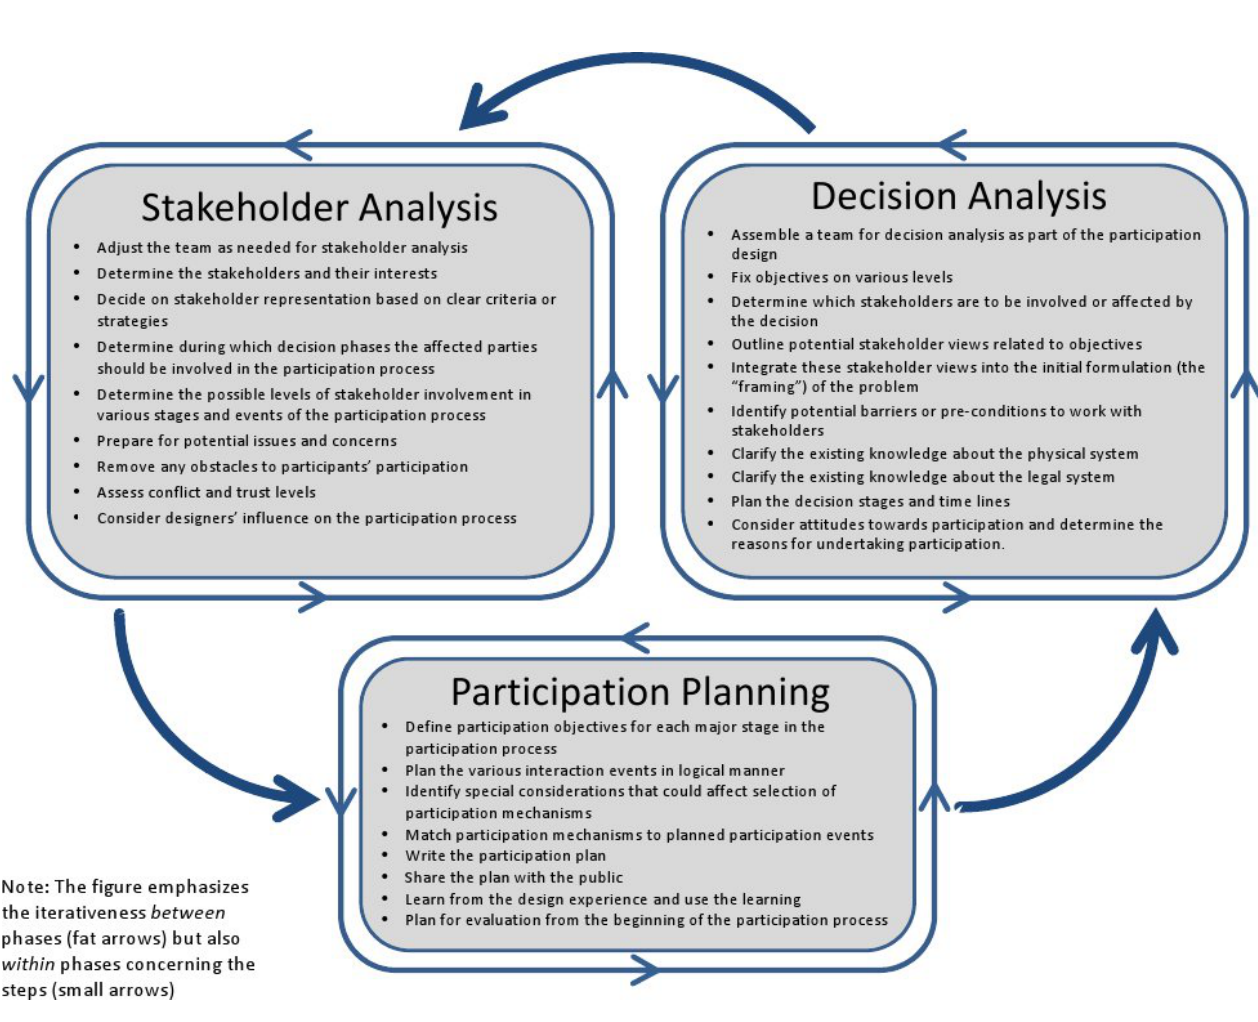
Fig. 2. A model for the new